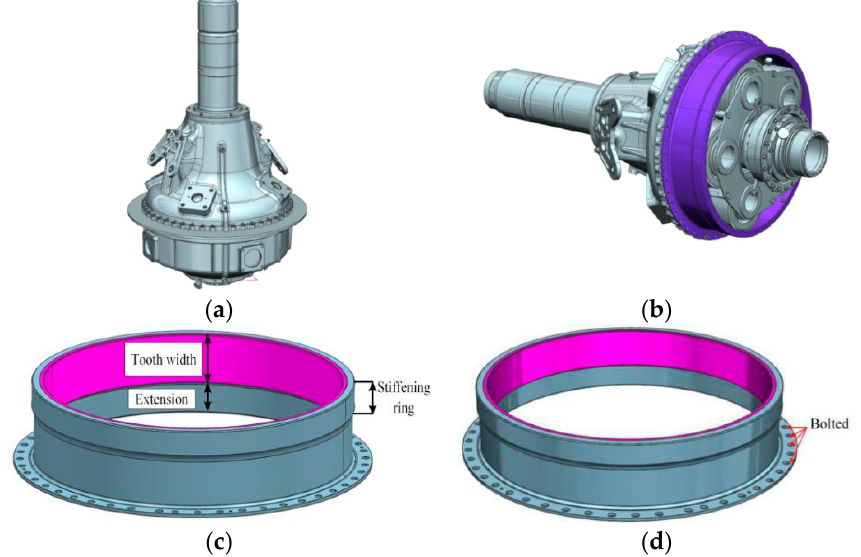
Figure 1. Three-dimensional diagram of L-shaped flexible ring gear and its planetary transmission system. ( a ) Main reducer, ( b ) planetary transmission system, ( c ) structural sketch, and ( d ) fixed form.